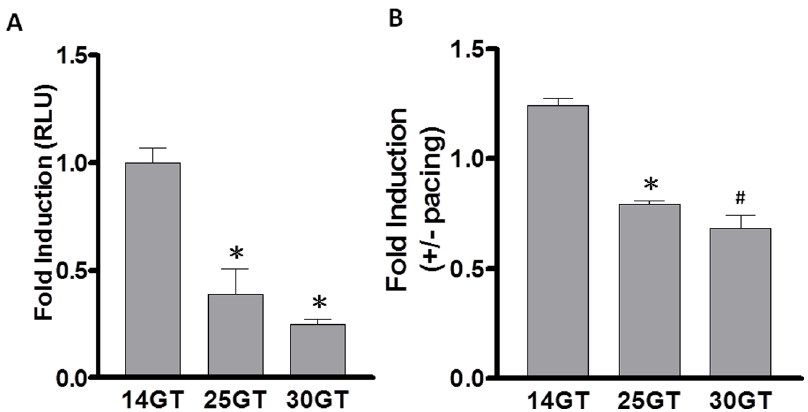
Figure 2. GT-repeats modulate the transcriptional activity of HO-1 gene and its responsiveness to rapid pacing. ( A ) HL-1 cells were transfected with plasmids containing various lengths of GT-repeats in the HO-1 promoter for 24 hours. The luciferase activity was assayed as described in Methods. ( B ) HL-1 cells were transfected with plasmids containing various lengths of GT-repeats in the HO-1 promoter for 24 hours and/ or subsequently received tachypacing (4 Hz) for 2 hours. Each value (mean 6 SE, [n=4]) is expressed as a fold change of luciferase activity relative to the control condition. P , 0.05; *, # : the different symbols represent the significant difference among groups.